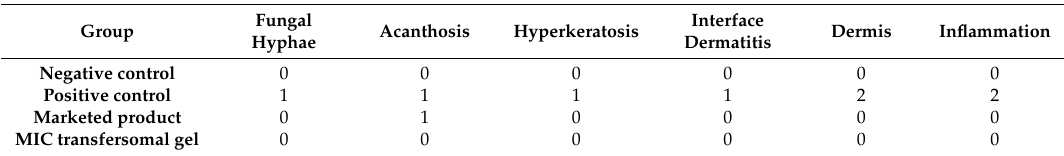
Table 10. Scoring system of histopathological examination of antifungal activity for MIC transfersomal gel compared to the marketed